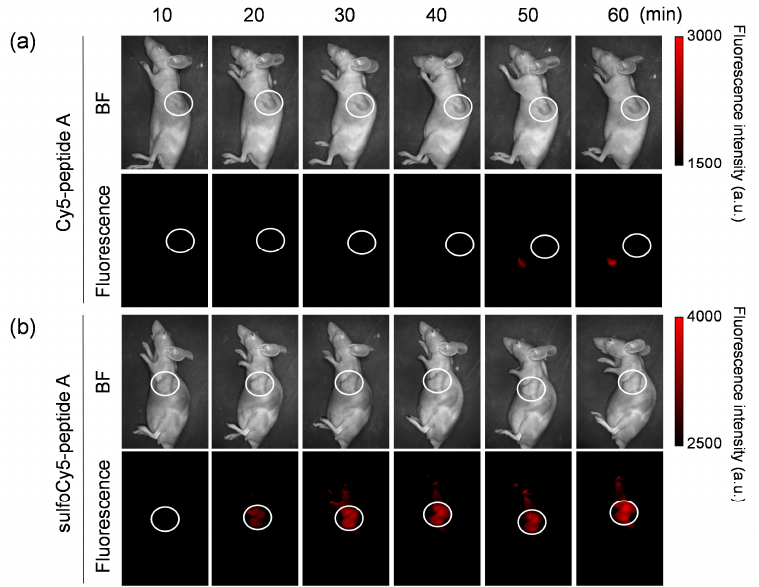
Figure 5. In vivo fluorescence imaging of tumor-bearing mice injected with dye-peptide A. The tumor-bearing mice were intravenously given 0.1 mL of ( a ) 100 µ M Cy5-peptide A and ( b ) 100 µ M sulfoCy5-peptide A. Ten minutes after the injection, the images were taken from a side view. The tumor is indicated by white circles. The in vivo experiment was performed three times.